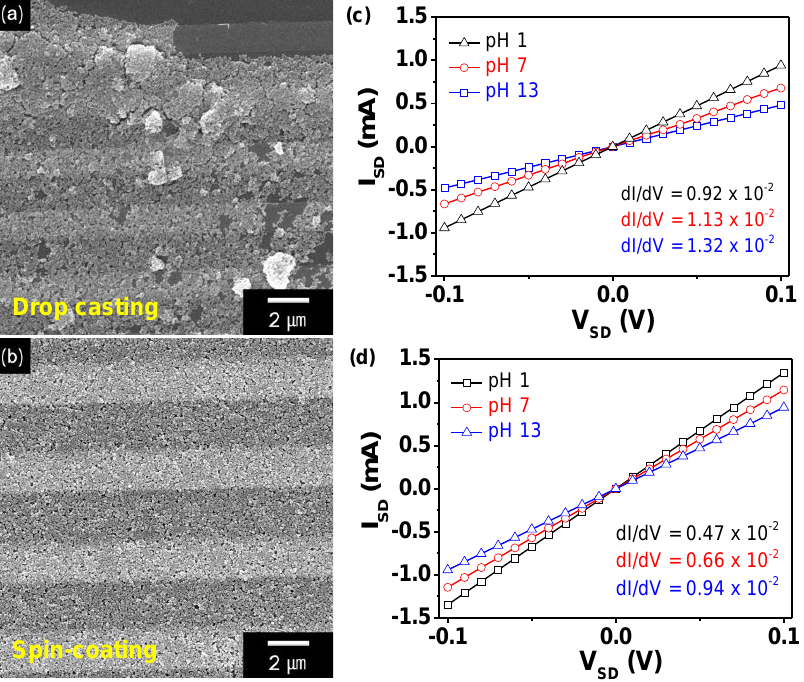
Figure 6. ( a , b ) Field emission scanning electron microscopy (FE-SEM) images and ( c , d ) source-drain voltage-current curves of the PPyNP-decorated sensor electrodes prepared by ( a , c ) drop-casting or ( b , d ) spin-coating.